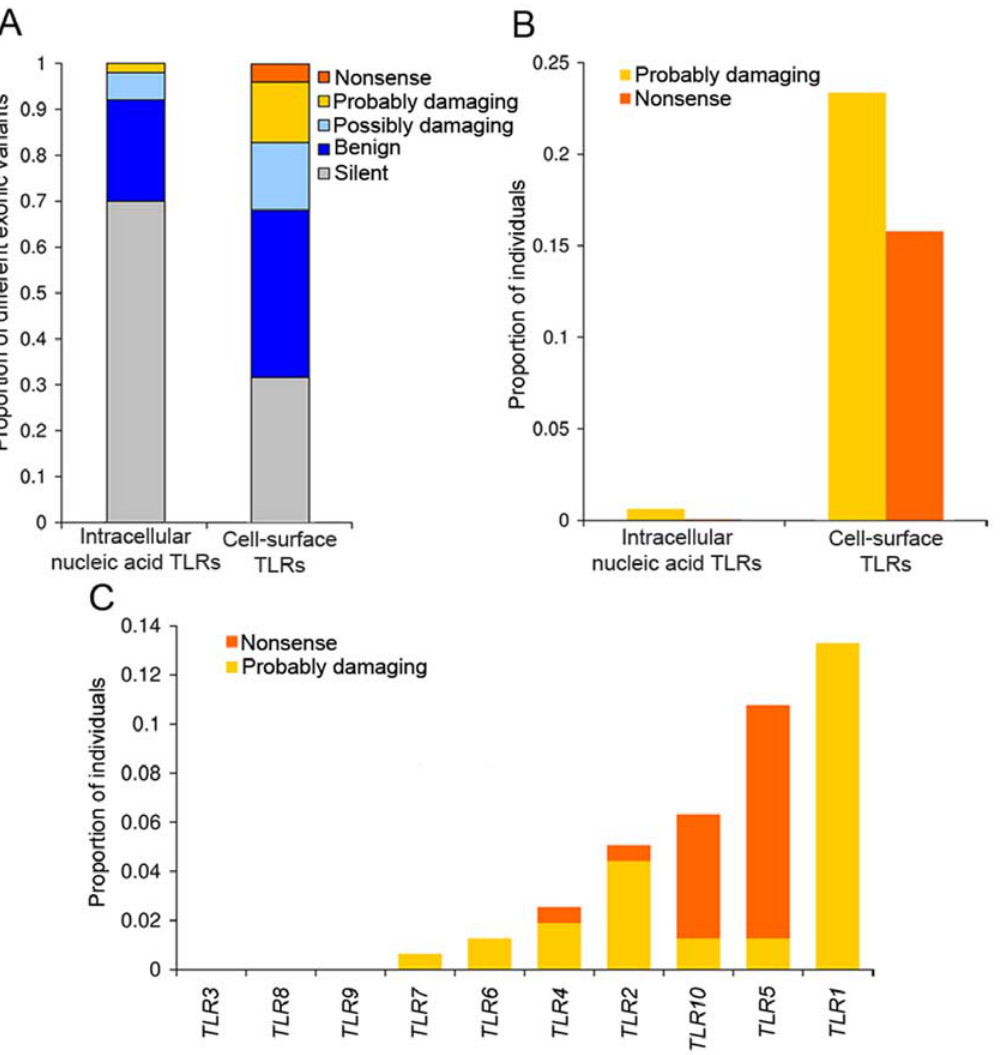
Figure 3. Functional diversity is unevenly distributed between the two groups of TLRs. (A) Distribution of the different classes of exonic polymorphisms (silent, stop, and the nonsynonymous variants considered to be benign, possibly damaging or probably damaging) between intracellular nucleic acid sensors and cell-surface expressed TLRs. (B) Proportion of individuals in the general population presenting a probably damaging or stop mutation in at least one TLR belonging from either of the two groups of TLRs. (C) Proportion of individuals in the general population presenting at least a probably damaging or a stop mutation for each individual TLR. The protein domains targeted by each of the nonsynonymous mutations identified are shown in Figure S9 for TLRs sensing nucleic acids, and in Figure S10 for the remaining